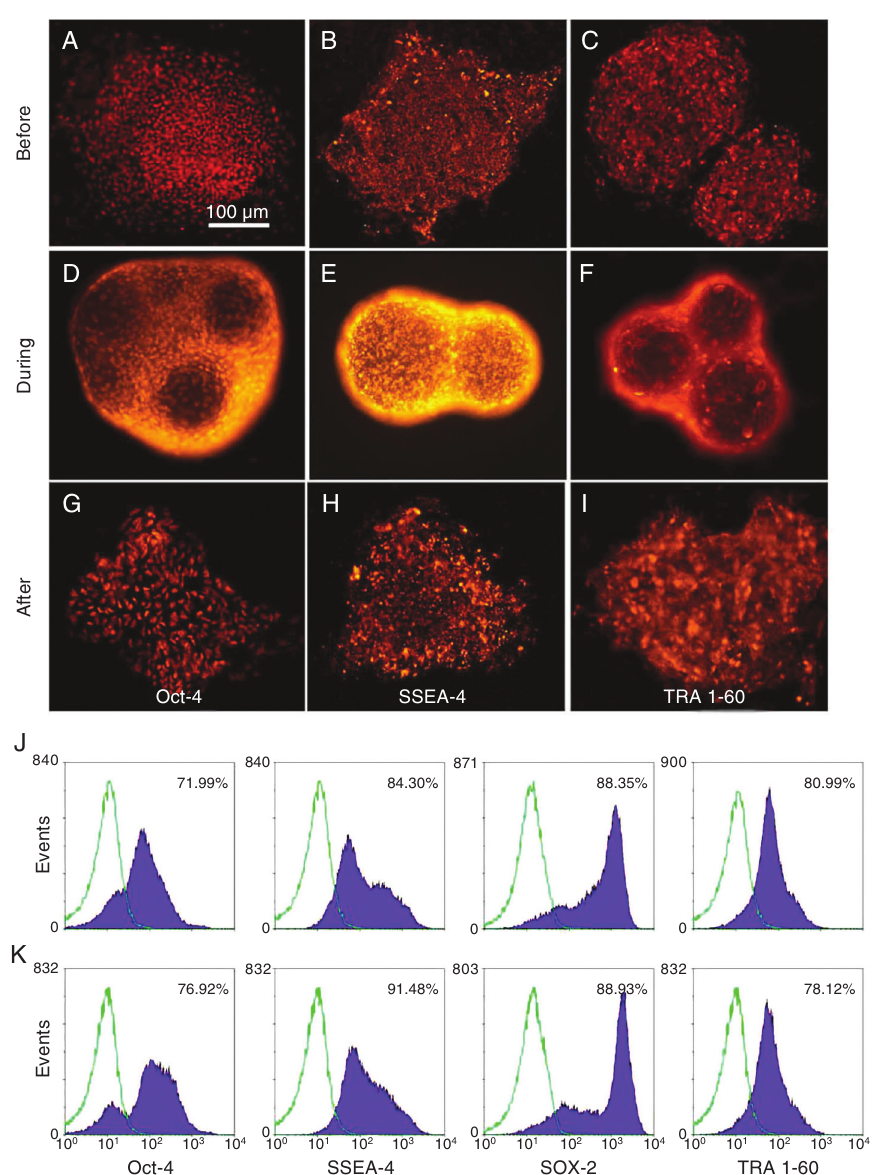
Figure 2. Pluripotency analysis: A-I, immunocytochemistry of H9 human embryonic stem cells (P33) for Oct-4, SSEA-4 and TRA 1-60 before, during and af- ter cell growth in spinners. Cells sampled from spinners were replated onto inactivated mouse embryonic fibroblasts and cul- tured for 2 weeks before the im- munocytochemical analyses (scale bar: 100 μ m). J-K, FACS results of human embryonic stem cells before (J) and after (K) cell culture in spinners, for each of the four markers ana- lyzed (Oct-4, SSEA-4, SOX-2, and TRA